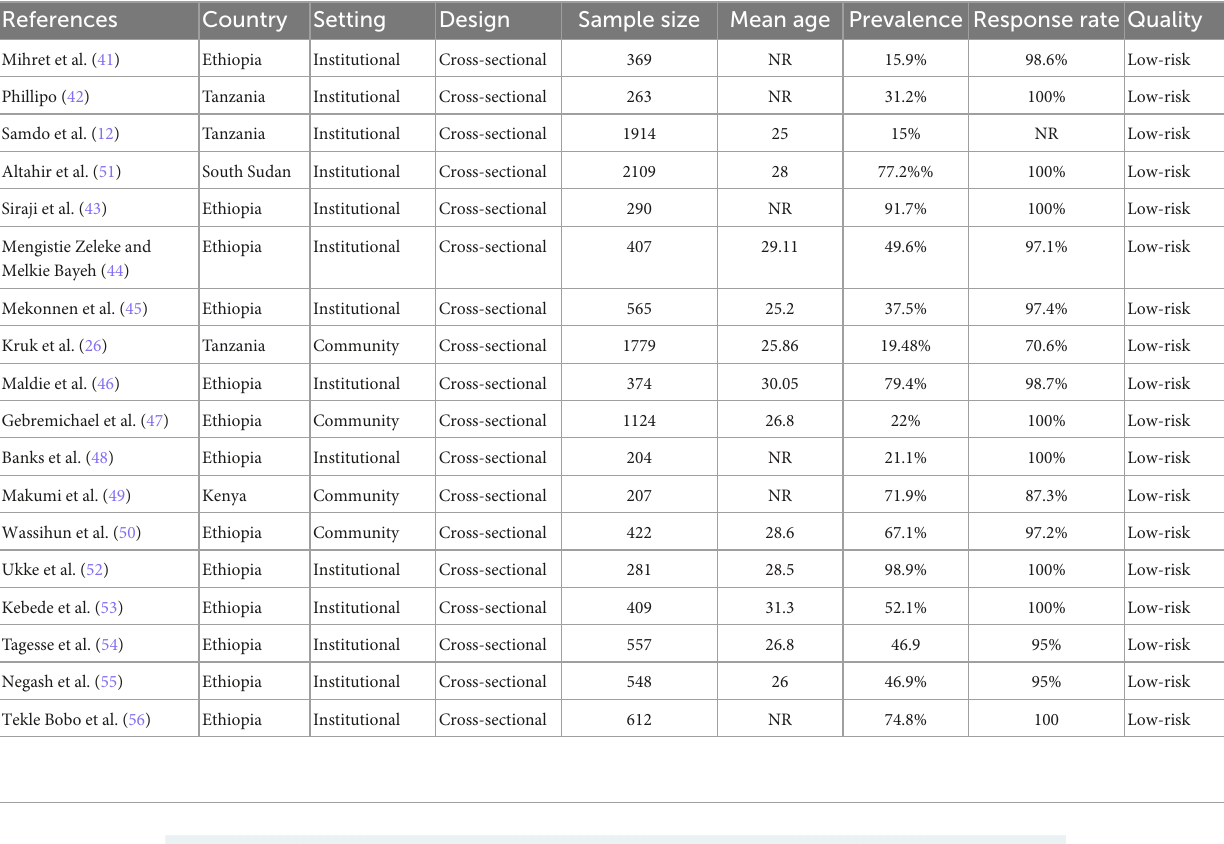
TABLE 1 Characteristics of studies included in the systematic review and meta-analysis of disrespect and abuse of women during childbirth in East Africa.